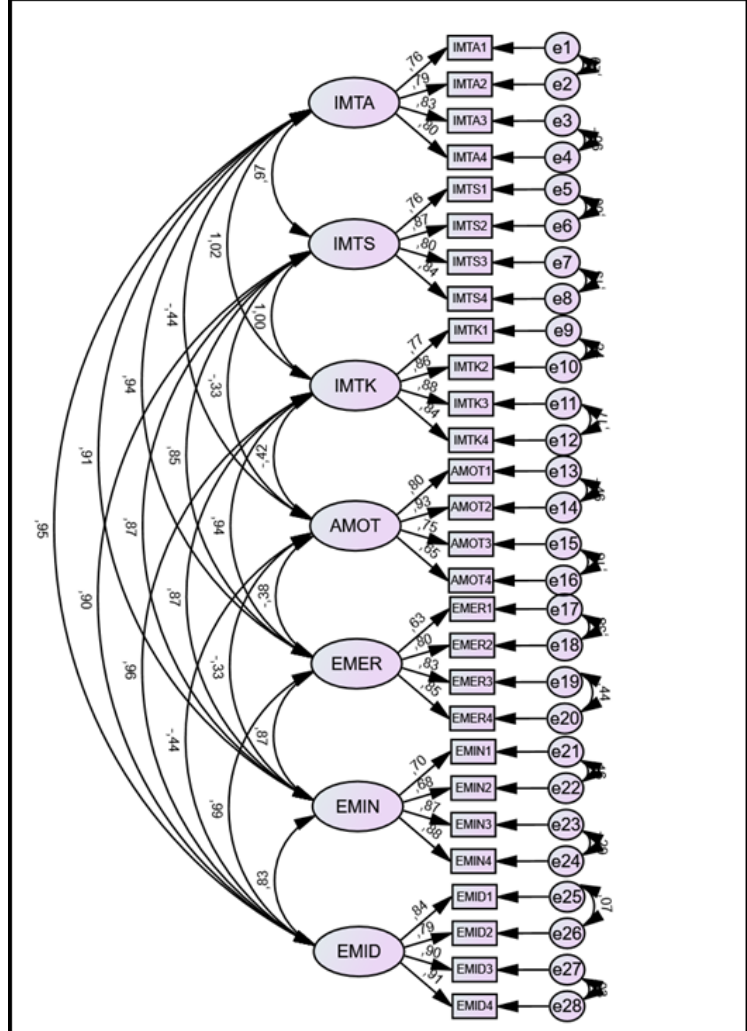
Figure 2. MATAMS final measurement model. Source: Created by the